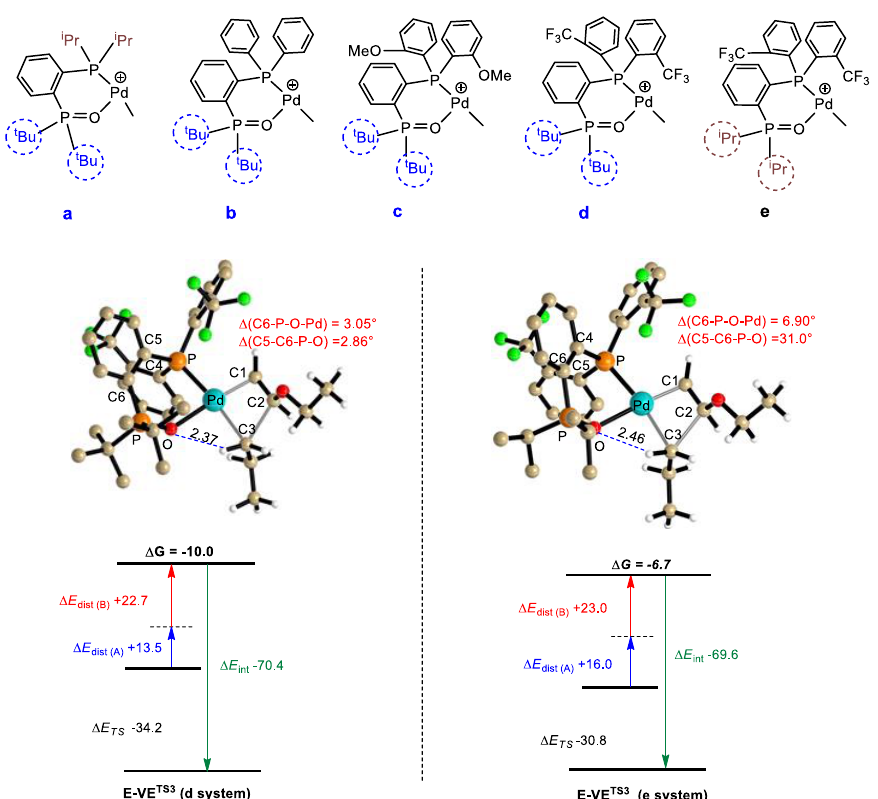
Figure 7. Distortion / interaction analysis of the transition state of catalyst d and e for transition states of copolymer formation stage (E-VE). All energies are calculated in kcal / mol unit and atomic distances are measured in Å. Dihedral angles are in degrees. Hydrogen atoms of the catalyst’s ligand have been omitted for clarity.